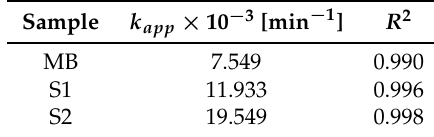
Table 1. Rate constants k app of photocatalytic methylene blue (MB) degradation and linear regression corelation coefficients R 2 .